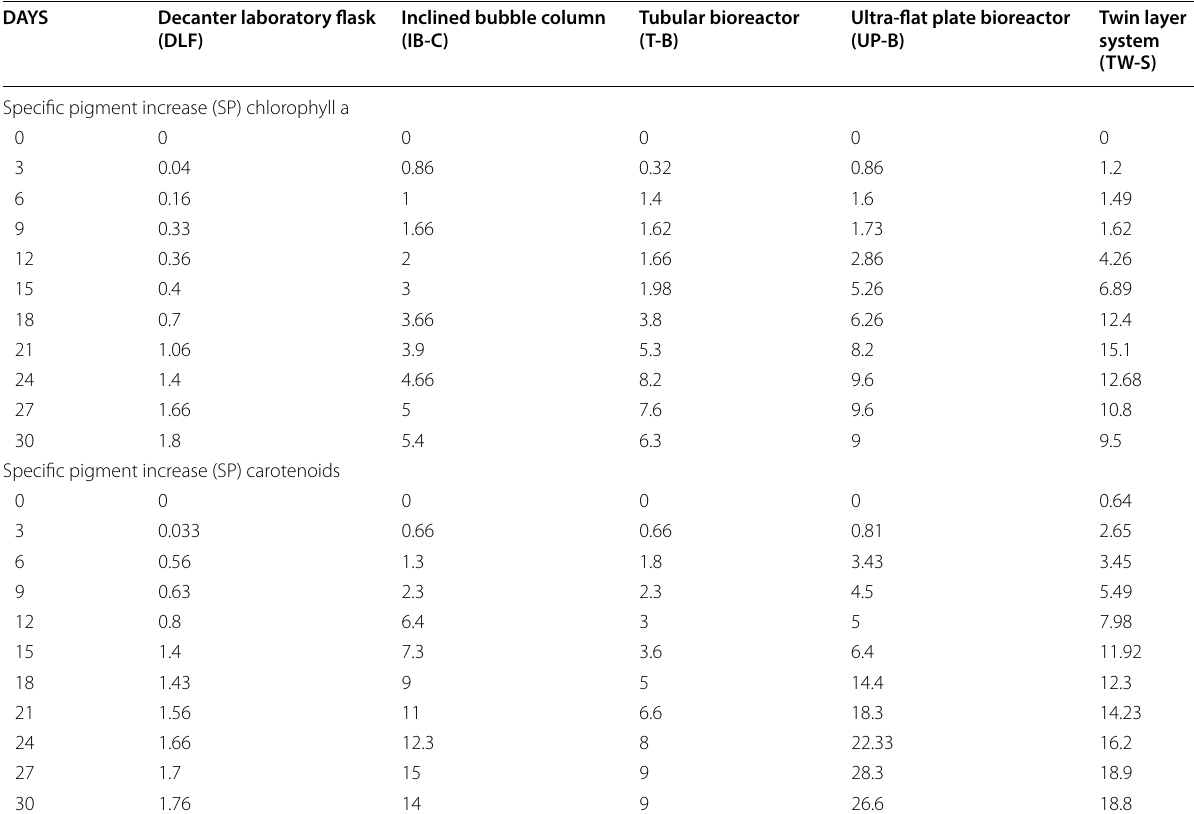
Table 2 Specific increase of pigments in different systems DAYS